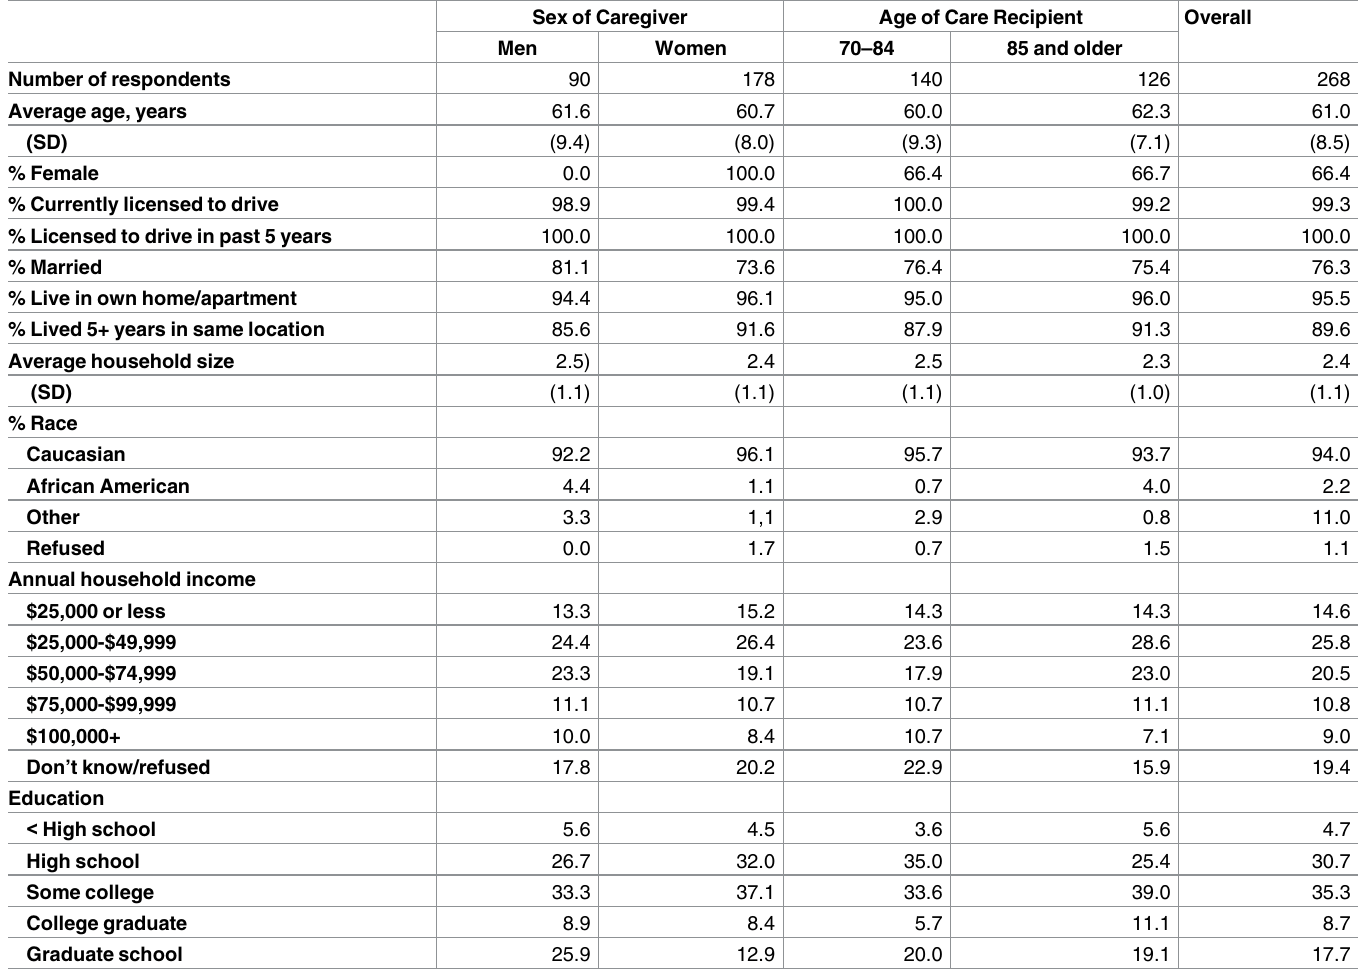
Table 1. Transportation caregiversample demographics by sex, age of care recipient, and overall.